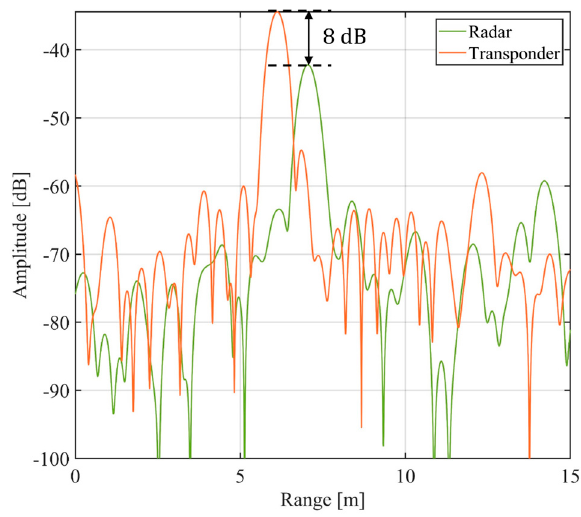
Figure 7. Experimental setup for verification of Equation (1): ( a ) picture of experimental setup, ( b ) block scheme used.